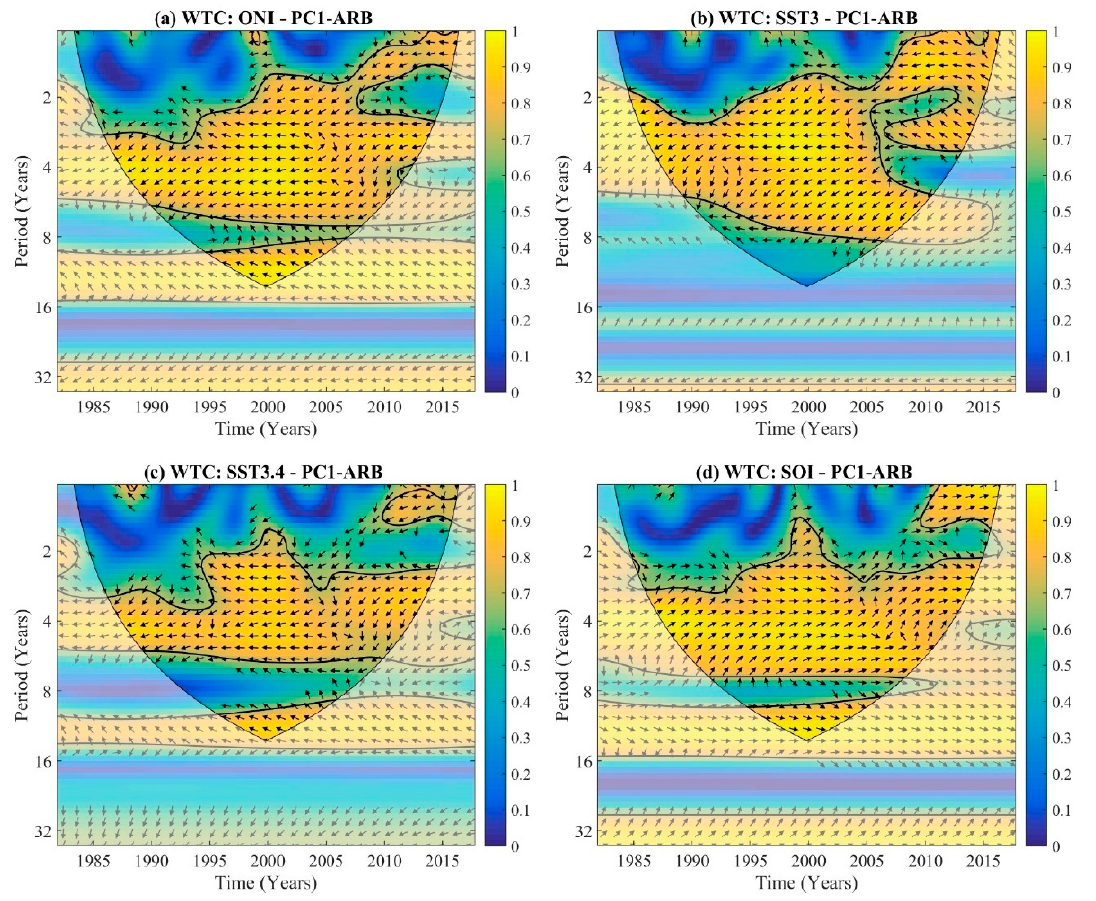
Figure 8. Wavelet coherence and phase differences between the PC series at ARB and ( a ) ONI ( b ) SST3; ( c ) SST3.4, and ( d ) South Oscillation Index (SOI). The closed contours represent the squared wavelet coherence. The region where the edge effects are significant is under the U-shape curve (the cone of influence—COI). The arrows indicate phase differences as follows: in the phase (0°), pointing to the right; outside the phase (180°), pointing to the left; the first-time series leads the second by 90°, pointing downward; and the first-time series lags the second by 90°, pointing upwardly.